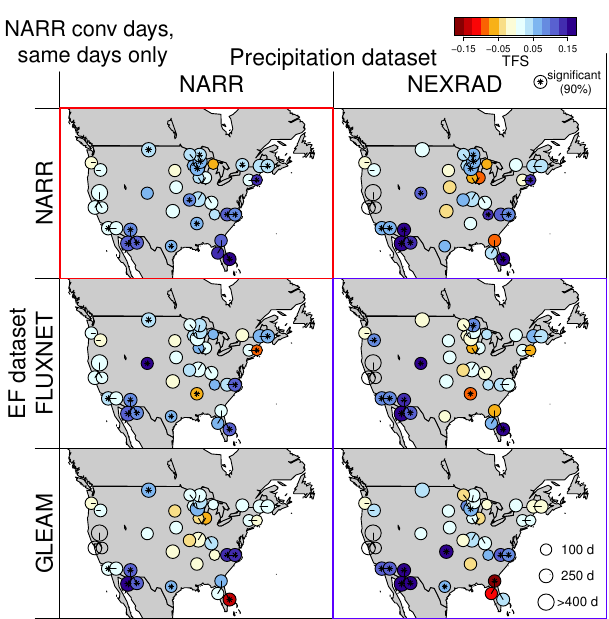
Figure 4. Influence of data set and sample size on TFS ∗ . Only days with data in all data sets are included in the computation, and potentially convective days are further selected based on NARR (see Sect. 3.2). TFS ∗ from NARR is boxed in red; TFS ∗ from observation-based combinations in blue. The size of the dots in- dicates the number of days included in the computation according to the legend shown on the bottom right. TFS ∗ values significantly different from 0 at the 90% level are indicated by a black asterisk. Empty dots indicate sites with unreliable NEXRAD